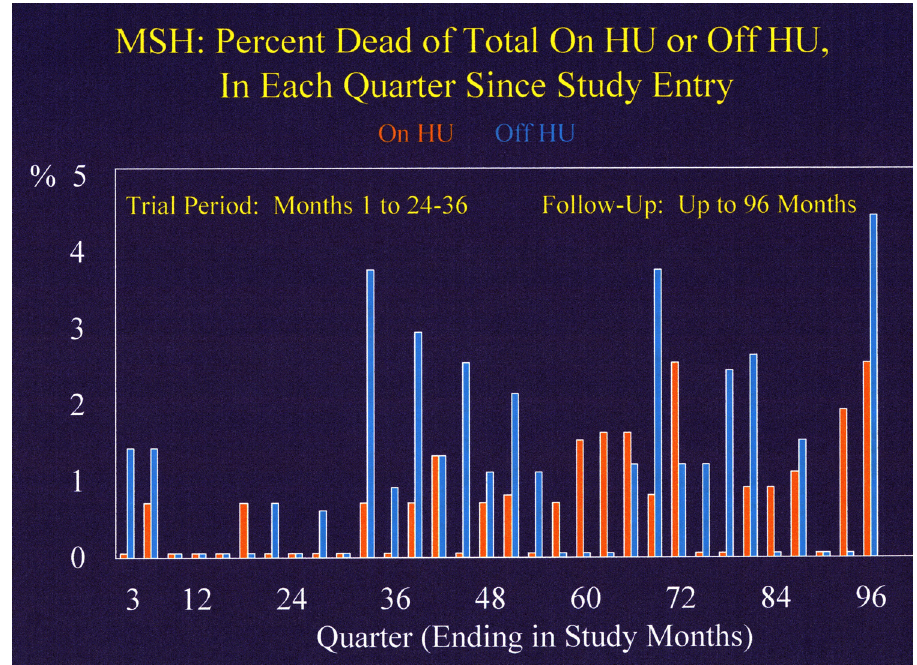
FIGURE 3. Mortality by 3-month intervals in patients taking (blue bars) or not taking (orange bars) hydroxyurea. Patients on hydroxyurea had reduced mortality ( p =